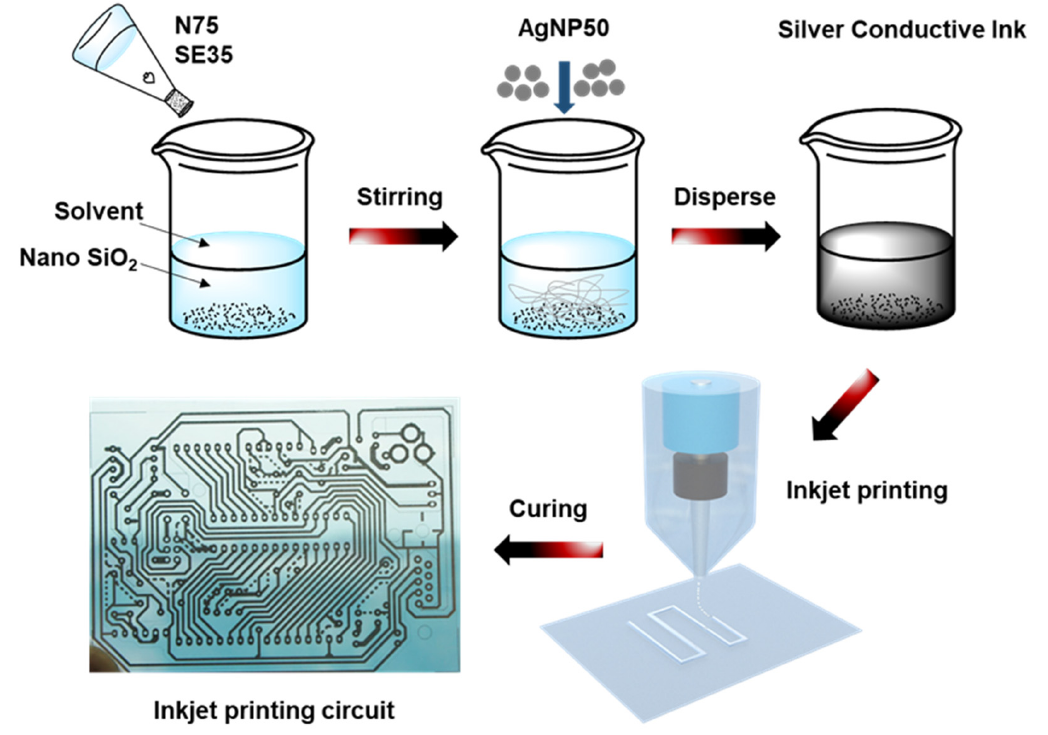
Figure 4. Preparation of silver conductive ink.